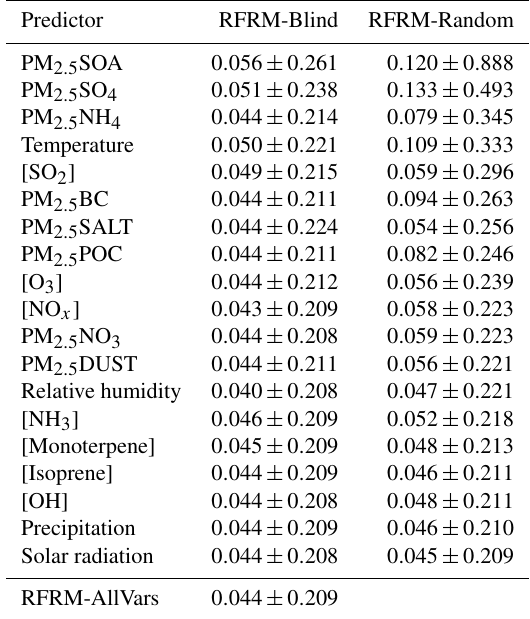
Table 3. Mean fractional bias (MFB) of each random forest regres- sion model (RFRM). RFRM-Blind refers to the RFRM trained ig- noring the particular predictor. RFRM-Random refers to the ran- domization of the particular predictor before input into RFRM- AllVars. RFRM-AllVars (at the bottom of the table) is the base- line model where no variable is omitted or randomized. Values are median ± median absolute deviation of